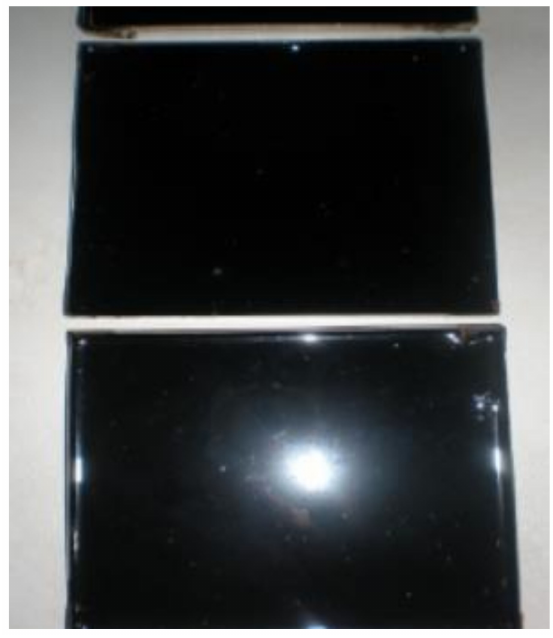
Figure 1. Asphalt slurry specimens.